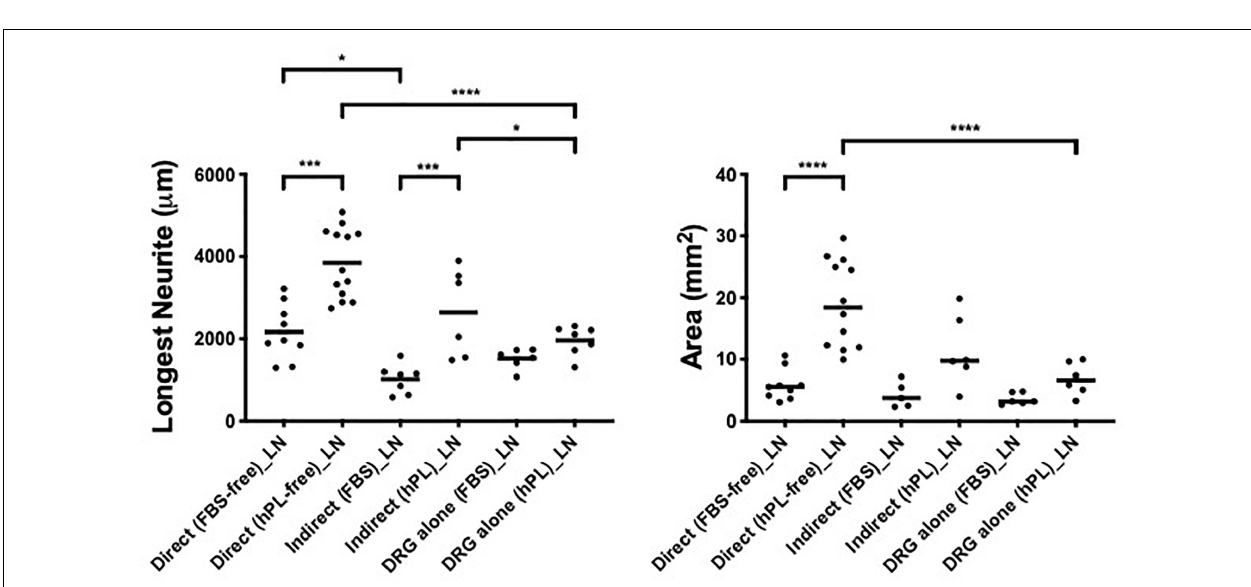
FIGURE 4 | hPL–hADSC secretome supports DRG outgrowth with high affinity for ECM molecules (condition 3—indirect co-cultures). Longest neurite and axonal area of indirect co-culture on ECM. Three biological repeats and at least three technical replicates (DRG) were assessed. One-way ANOVA with Tukey’s multiple comparison tests was used for assessing statistical significance among the examined groups (* p < 0.05, ** p < 0.01, *** p < 0.001, **** p < 0.0001). The number of DRG tested corresponds to the number of dots for each condition in the graph.